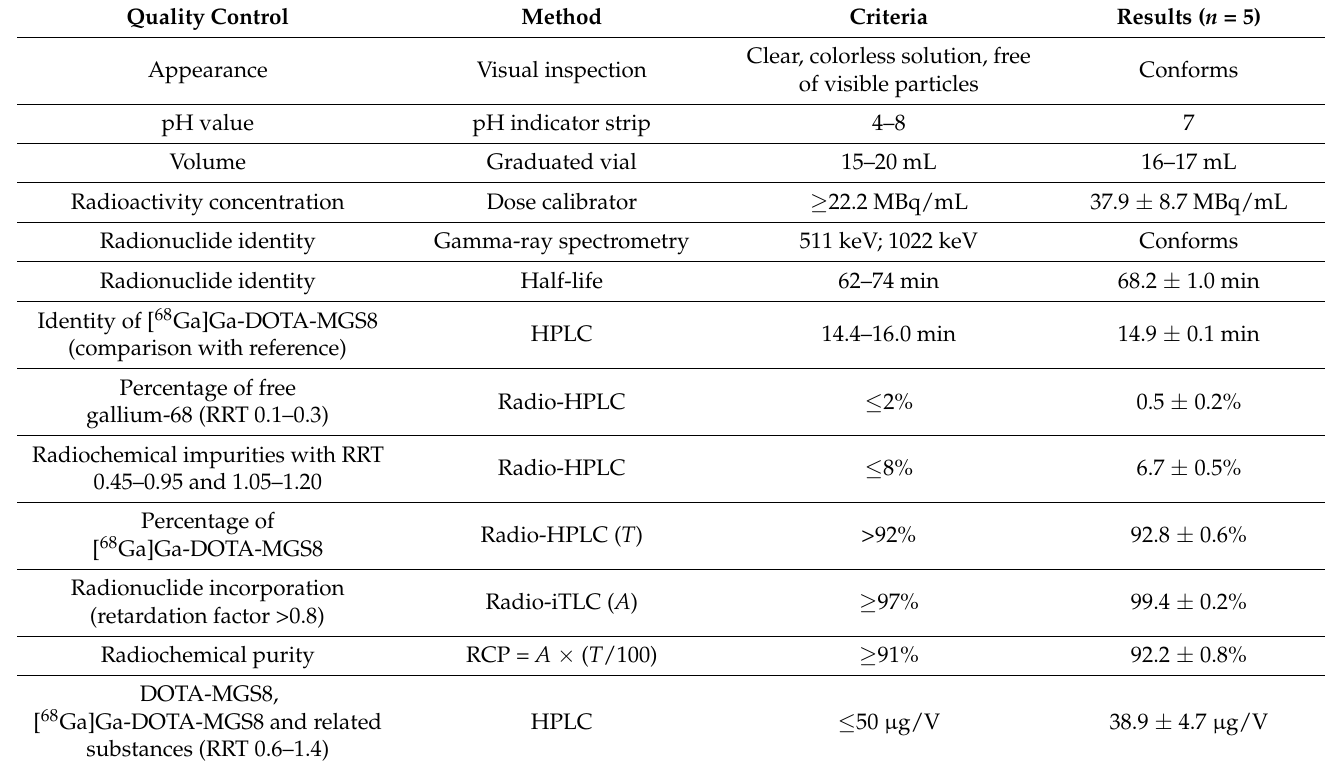
Table 1. Pre-release analyses of five batches of [ 68 Ga]Ga-DOTA-MGS8.